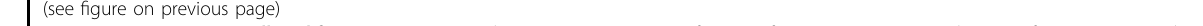
Fig. 2 USP21 promotes cell proliferation in vitro. a Relative mRNA expression of USP21 after overexpression or silencing of USP21 compared with an empty vector control (nc) in A549 and NCI-H460 cells; n = 3. b Western blot analyses of USP21 after overexpression or silencing of USP21 compared with an empty vector control (nc). β -Actin was used as an internal control. c Cell proliferation was measured using an MTT assay at 24, 48, 72, and 96 h after transfection with the overexpression USP21 vector compared with the empty vector in A549 and NCI-H460 cells. d Cell proliferation was determined using the MTT assay at 24, 48, 72, and 96 h after silencing of USP21 or treating with the empty vector in A549 and NCI-H460 cells. e Representative images of tumor samples after 21 days of inoculation in nude mice models. Tumor weight was measured at the endpoint post 21 days, and the tumor volume was measured throughout the 21 days of inoculation. n = 5 mice per group in e . Each value is presented as the